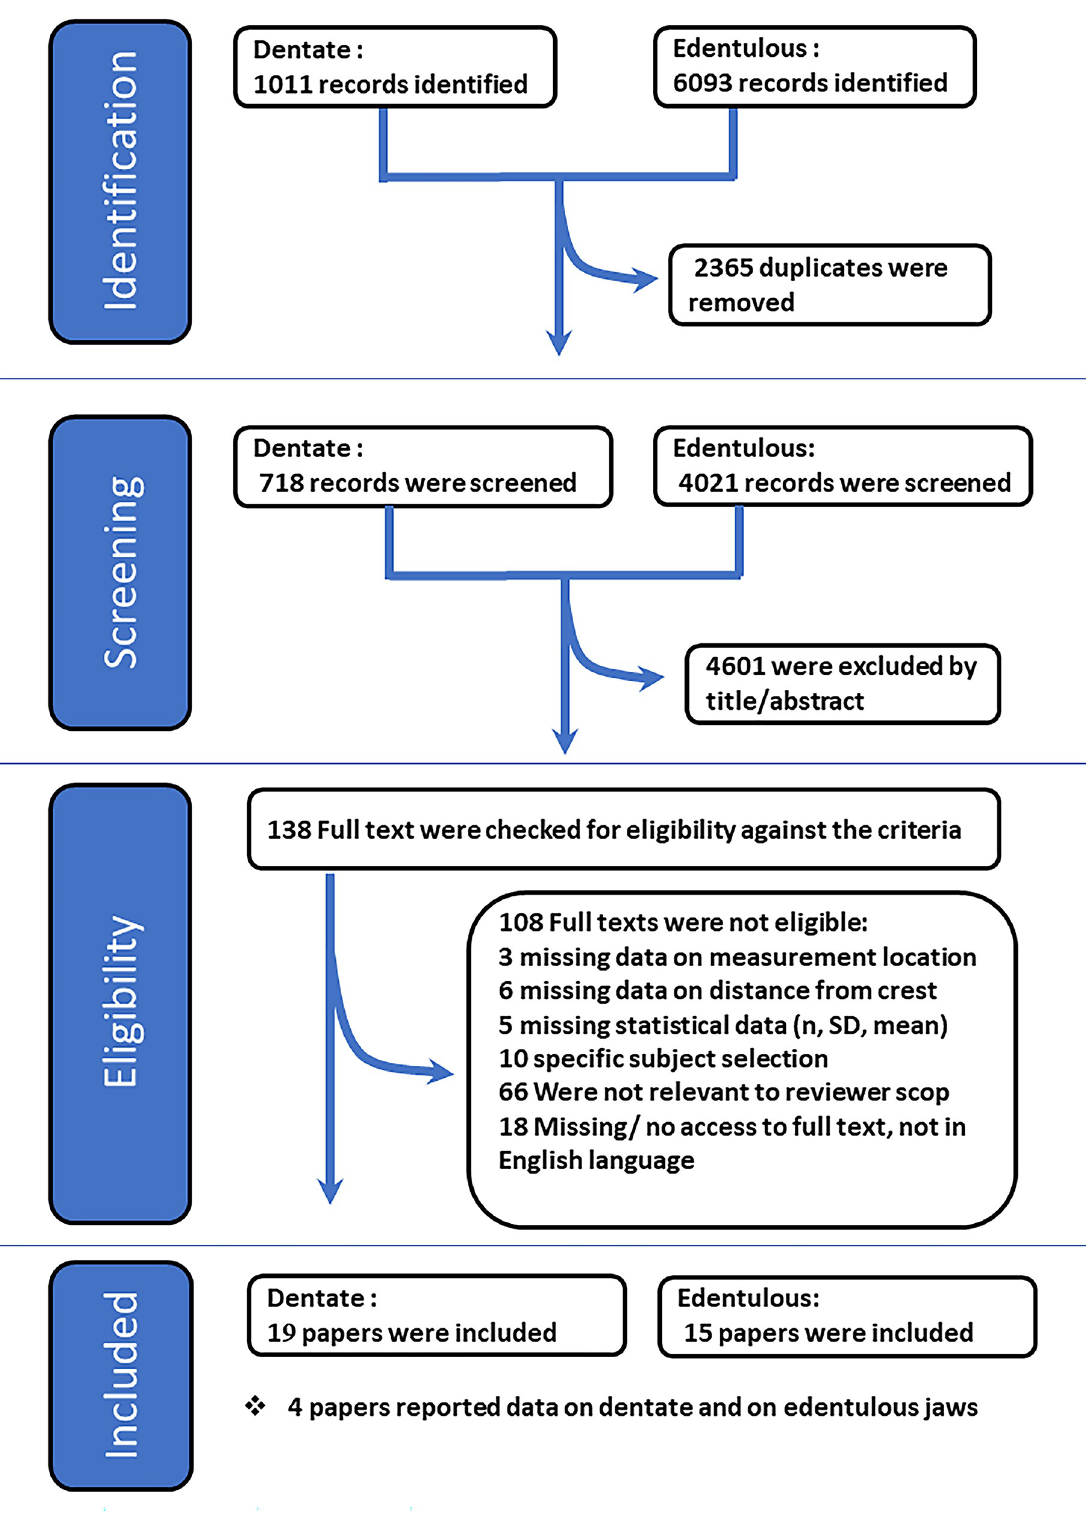
Fig 2. Search and article selection